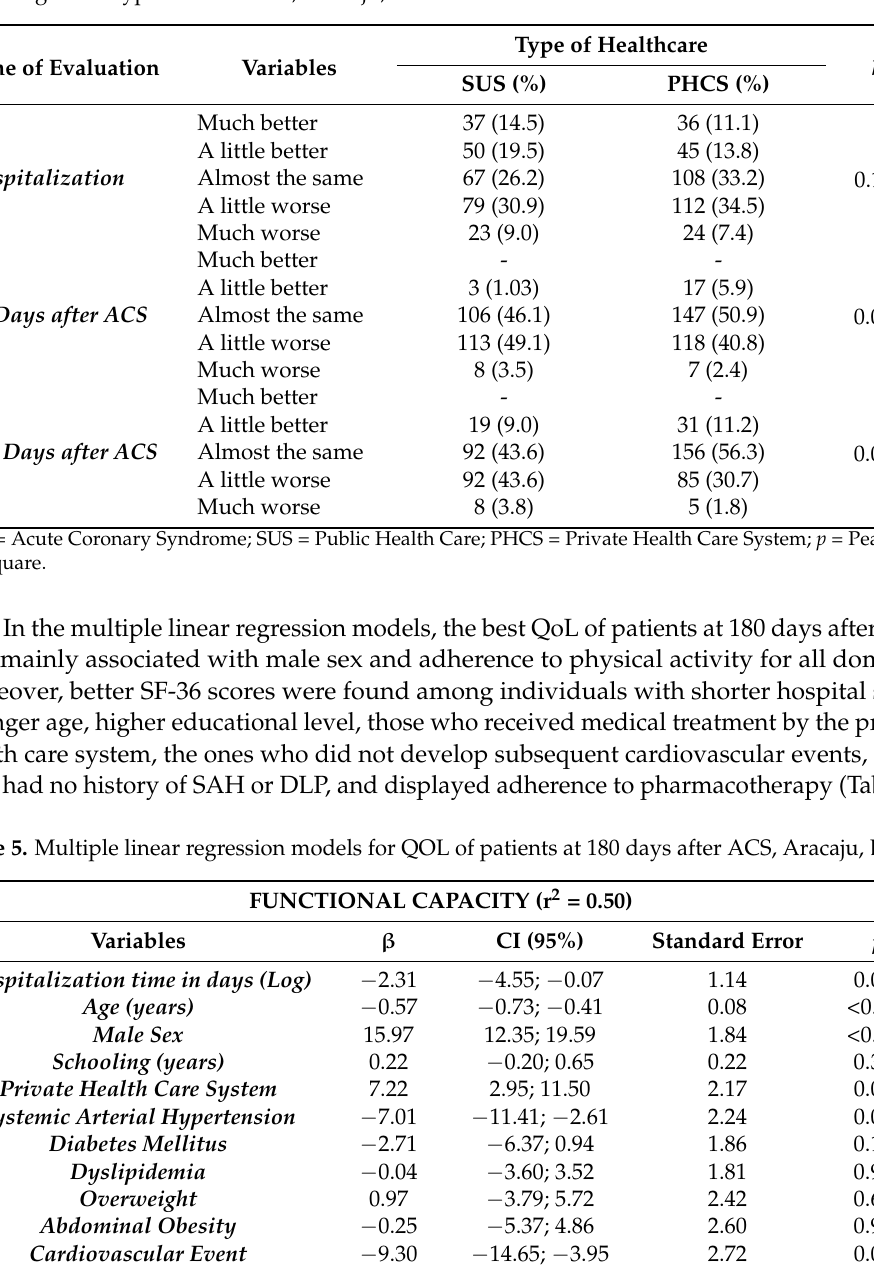
Table 4. Perception of patients with ACS concerning their current health compared to a year ago, according to the type of healthcare, Aracaju, Brazil.